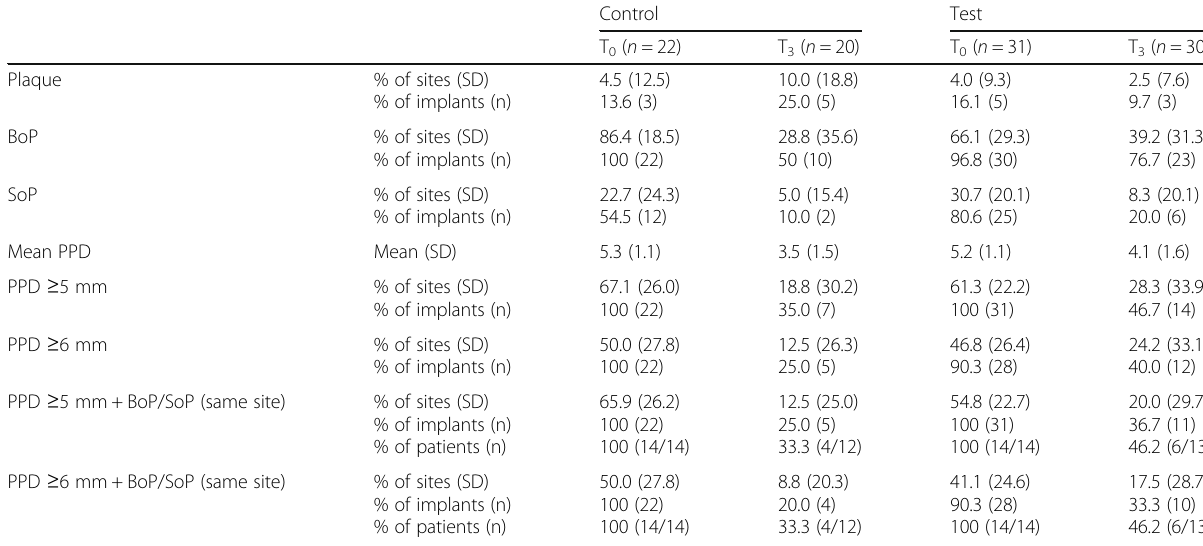
Table 4 Descriptive statistics of clinical parameters